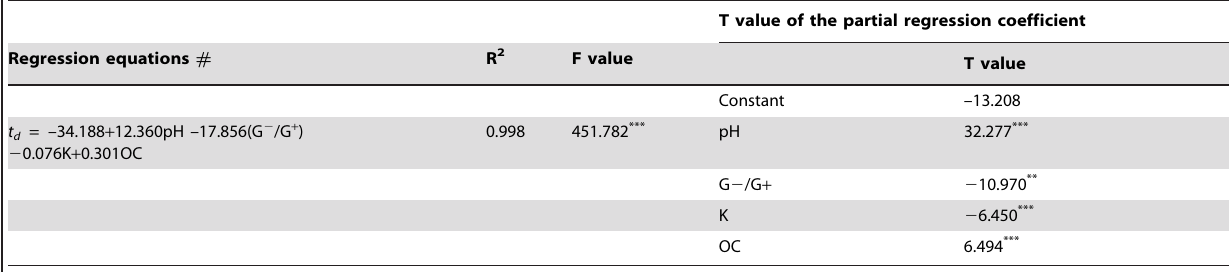
T value of the partial regression coefficient